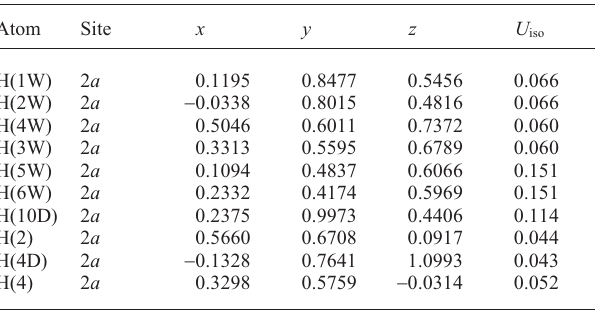
Table 3. Atomic coordinates and displacement parameters (in Å 2 ) .